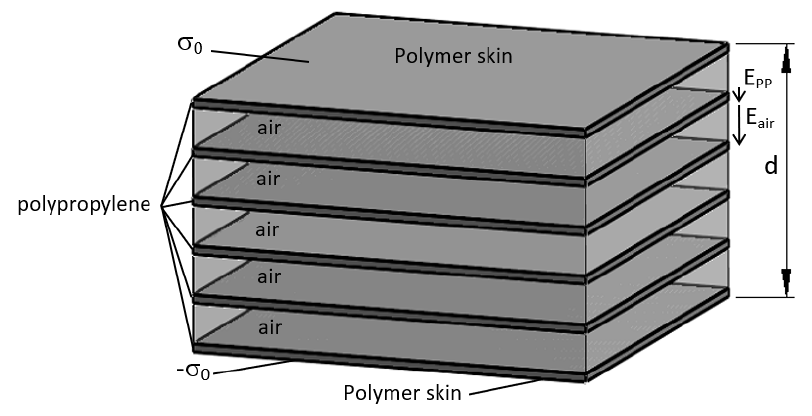
Figure 1. Image of a cross-section of the thin polypropylene films.